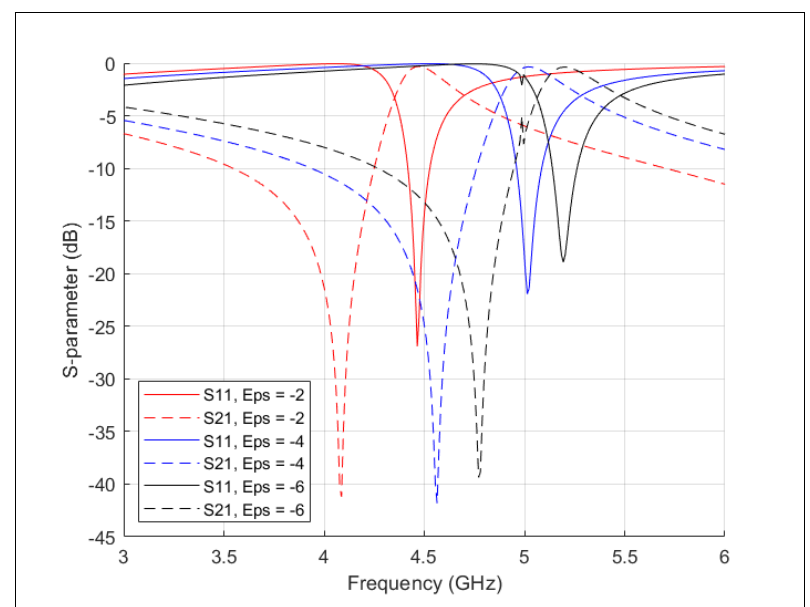
Figure 7. Passband variation with changes in the magnitude of the negative permittivity.